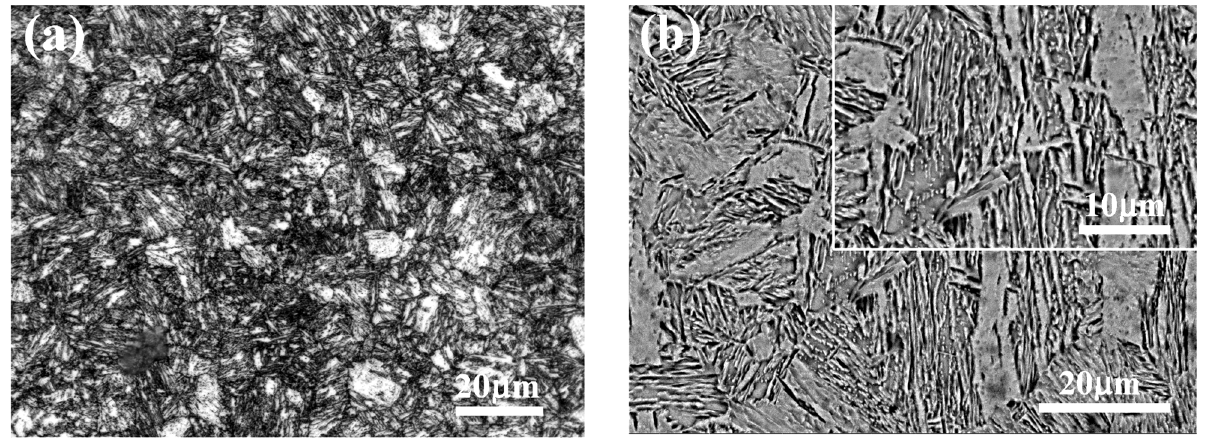
Figure 1. Metallographic structure of sample: ( a ) OM micrograph; ( b ) SEM micrograph.